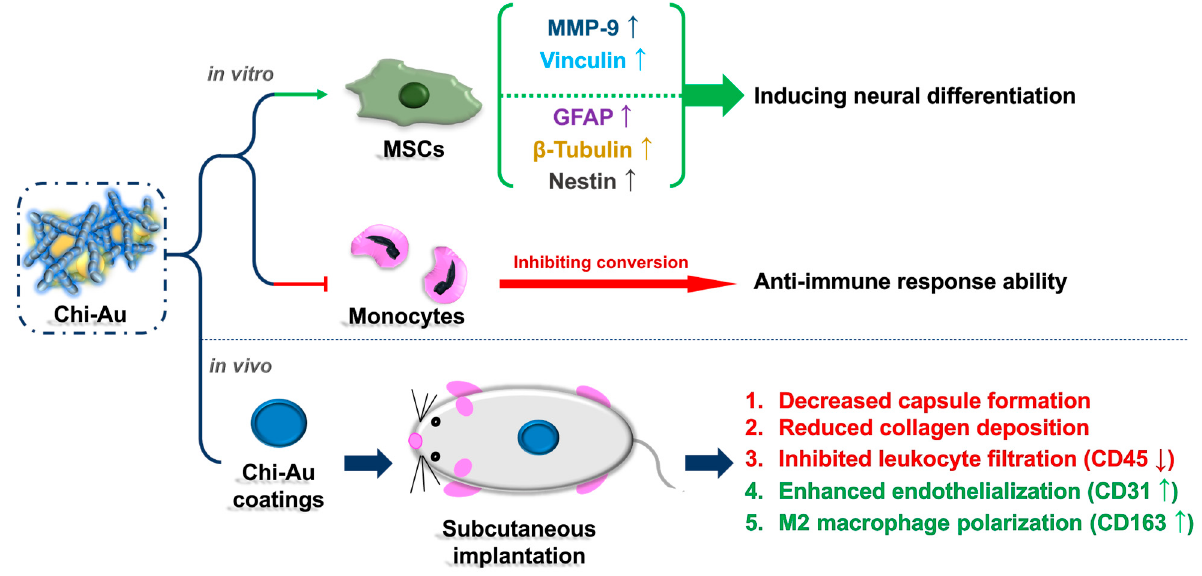
Figure 9. Summary illustrations for Chi–Au nanocomposites in in vitro and in vivo assessments. The summary shows that Chi combined with 50 ppm of Au nanoparticles can significantly induce neural differentiation. Furthermore, the animal model also indicated Chi–Au 50 ppm was a highly safe nanocomposite, indicating its potential for use in tissue engineering. The up and down arrows indicated the increased or decreased expression of protein and mRNA.